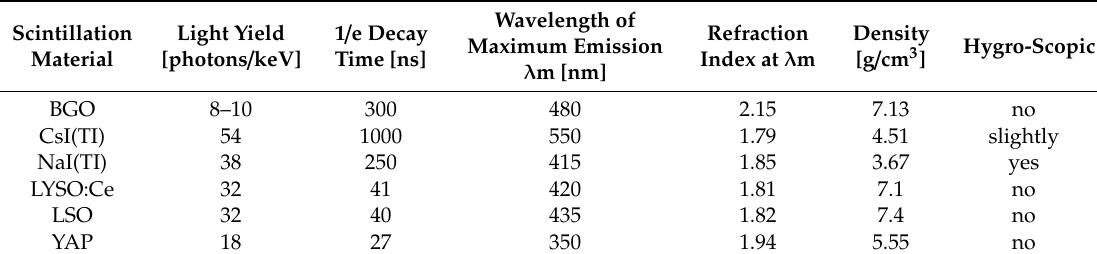
Table 1. Selected properties of inorganic scintillation materials useable for multi-plane detector applications